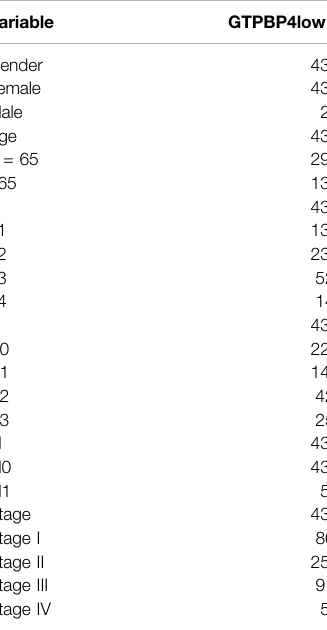
Figure 5A , the random effect model was used for analysis due to heterogeneity I 2 > 50%. The combined SMD was 1.31, 95%CI was (0.84, 1.78). GTPBP4 expression upregulation in breast cancer is thus